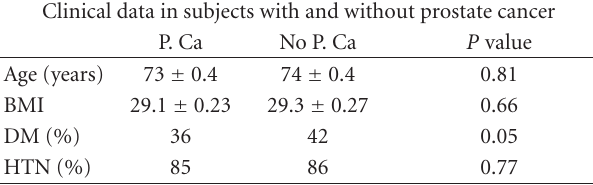
Table 1: Clinical parameters in subjects with prostate cancer compared to age-matched controls without prostate cancer. Clinical data in subjects with and without prostate cancer